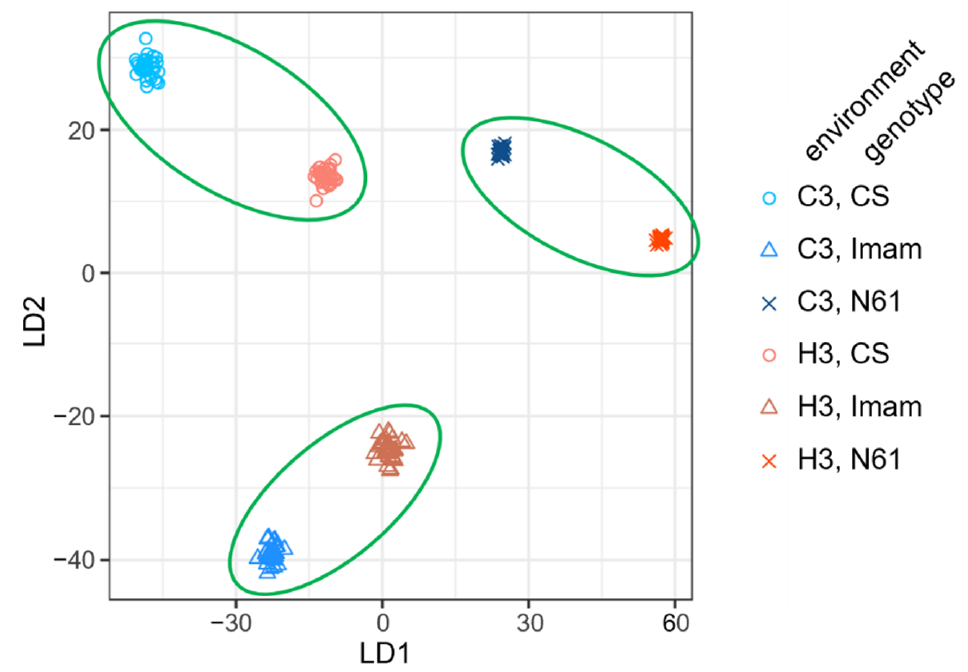
Figure 5. Scatter plot of LD1 and LD2 derived from the linear discriminant analysis (LDA). The LDs are the discriminate functions of the LDA model. Each point represents the LD1–LD2 coordinate for each FTIR spectrum. Symbols for the three genotypes and two environmental conditions are shown at the right of the panel. Green ellipses denote the location of each wheat genotype. To obtain information on the influential wavenumber regions in the FTIR spectra for discriminating different genotypes and environmental conditions, the coefficients of the LDs for each wavenumber were examined. The coefficient of LDs, or scaling value, indicates the loading or contribution of each wavenumber to the LD function, in such a way that higher absolute values of coefficients potentially show greater contribution to the discrimination [62]. A two-dimensional scatter plot of the coefficients showed that most of the wavenumbers were loosely clustered in the origin of the LD1–LD2 plain, whereas a considerable quantity of ‘characteristic’ wavenumbers deviated from the center (Figure 6A). One-dimensional plots of coefficients for either LD1 or LD2 versus wavenumbers revealed that several spectral regions, i.e., 400–800 cm − 1 , 1200–1300 cm − 1 , 1450–1550 cm − 1 ,